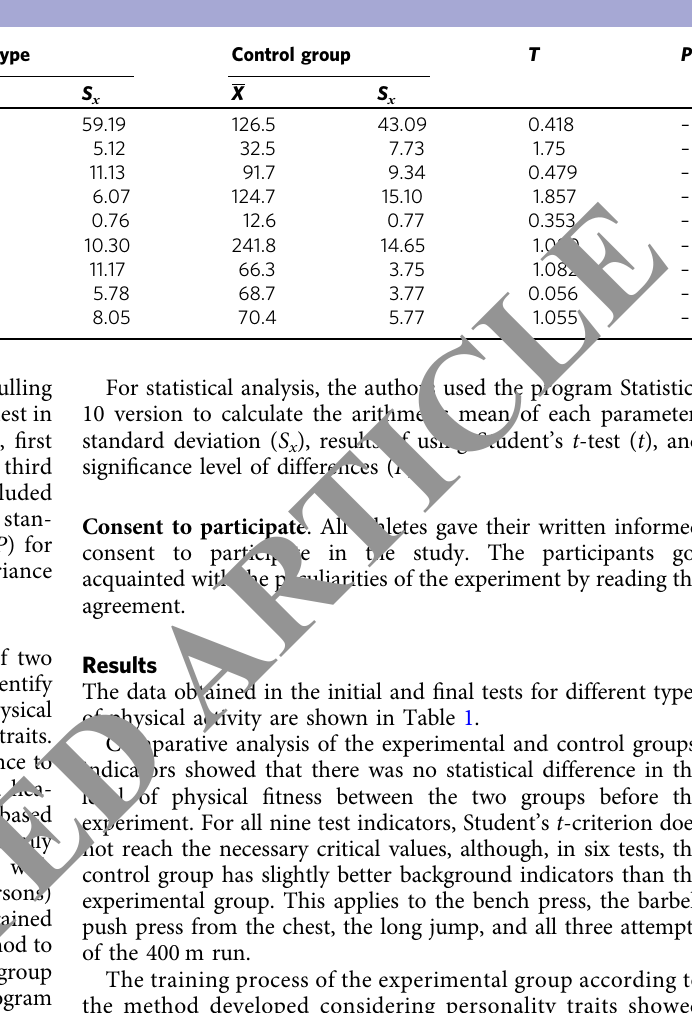
Table 1 Parameters of physical activity in the experimental and control groups for professional boxers at the beginning of the